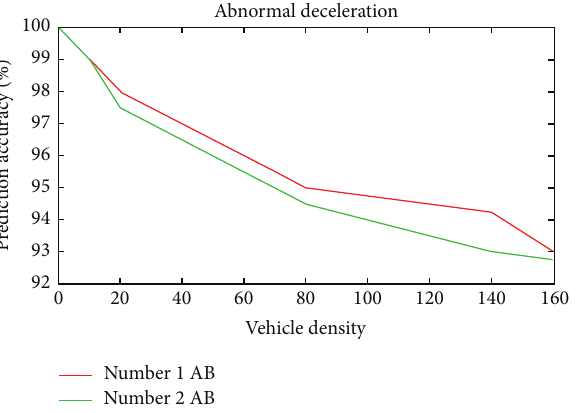
Figure 11: Prediction accuracy versus vehicle density for Scenario 1.